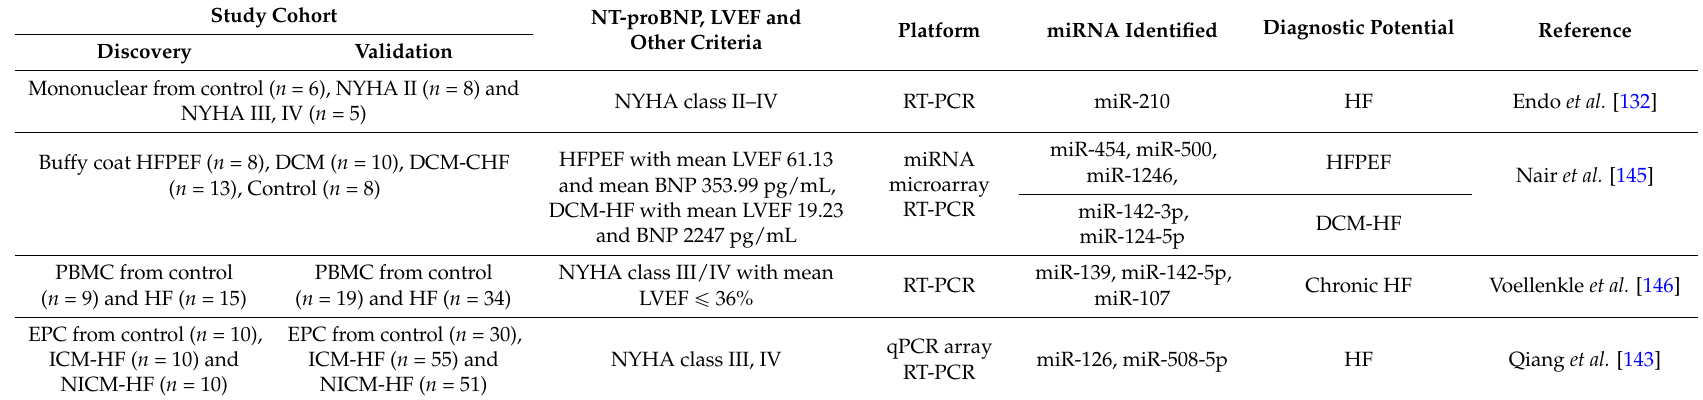
Table 8. Summary of reported miRNA as HF biomarker in peripheral blood mononuclear cells (PBMC) endothelial progenitor cells (EPC) and buffy coat